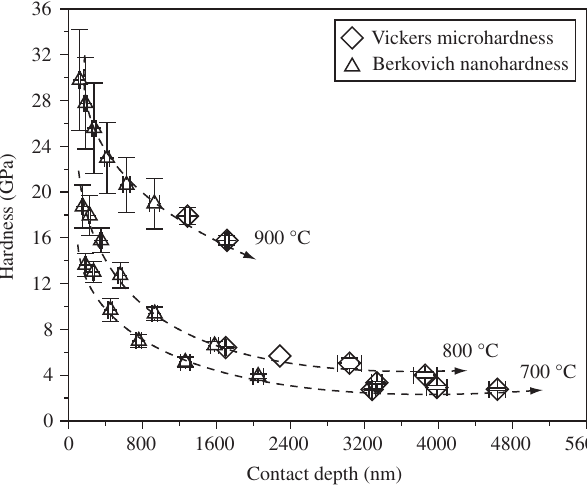
Figure 5. Hardness vs. contact depth for titanium samples nitrided at 700 °C, 800 °C and 900 °C and 20%N / 80%H atmosphere, corrected by the contact 2 2 stiffness analysis (  ). Vickers microhardness values are also shown (  ). The lines are a guide for the eyes.